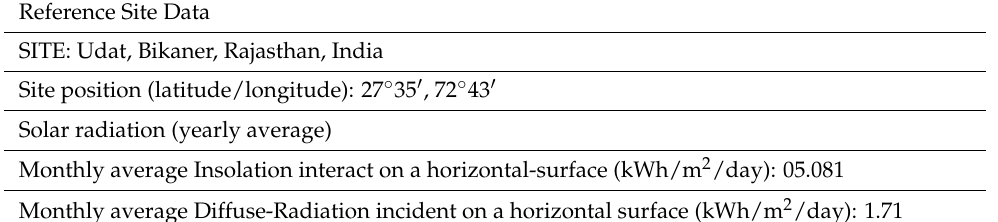
Table 2. Reference Site Data for SUTPP. Reference Site